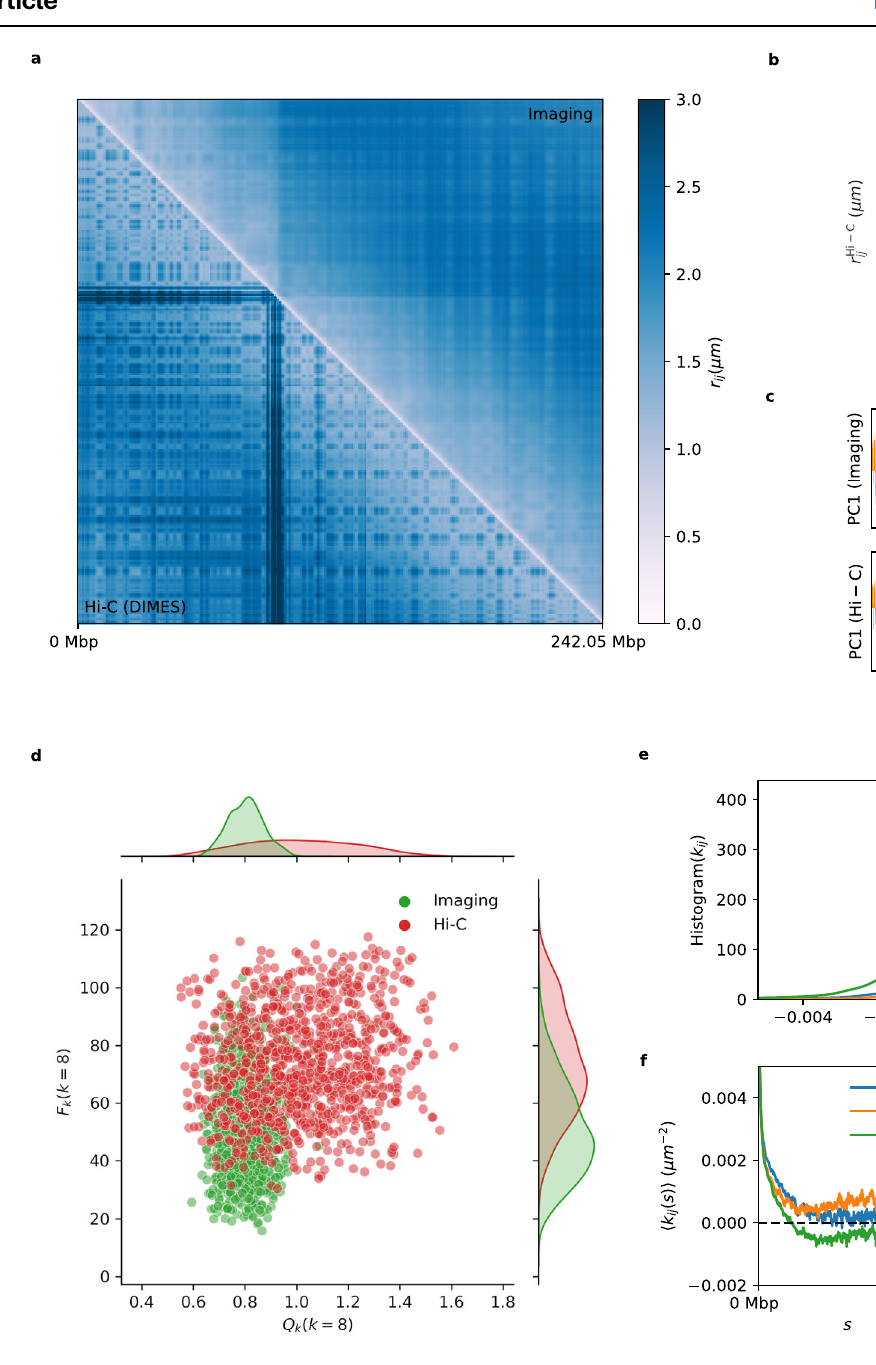
Fig. 9 | Structural organization calculated from Hi-C and imaging data. a Comparison between the mean distance matrix inferred from Hi-C contact map (lower triangle) and the experimental measured average distance matrix (upper triangle)for Chr2from the cell line IMR90.The distance scale is givenonthe right. b Direct comparison of pairwise distances, h r Imaging ij i versus h r Hi (cid:2) C ij i . Each dot represents a pair ( i , j ). Dashed line, with a slope of unity, is a guide to the eye. c Principalcomponentdimension1(PC1)forimagingandHi-Cdata.Thecorrelation matrix is computedfrom the connectivity matrix K , and then PCA is performed on